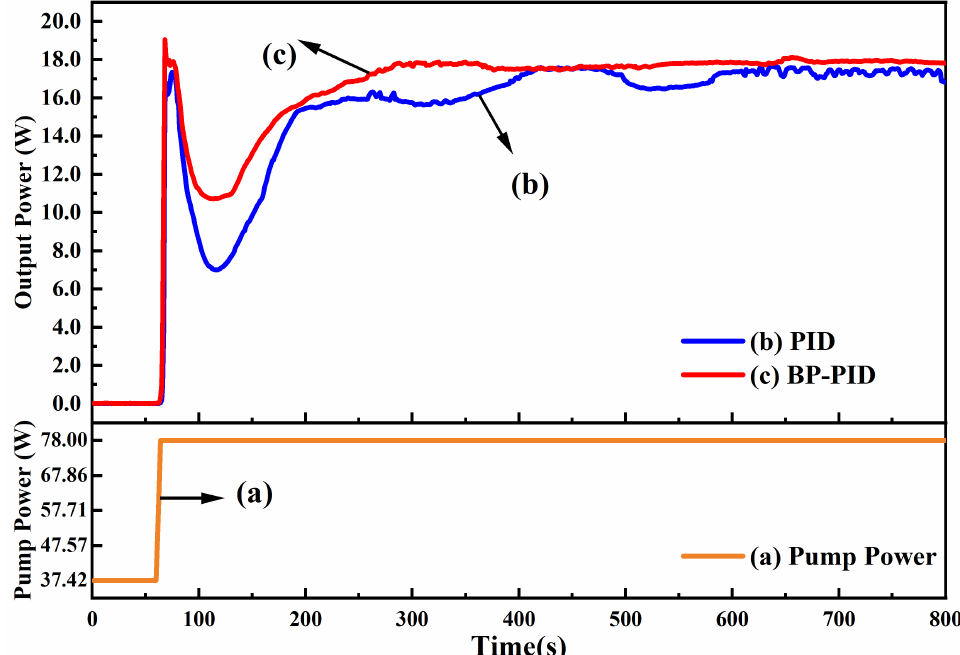
Figure 4. The change of the laser output power when the incident pump power increased from the threshold point to the optimal operating point. The orange line (a) was the change of the incident pump power, the blue line (b) was the laser output power of using traditional PID controller, and the red line (c) was the laser output power using BP neural network PID